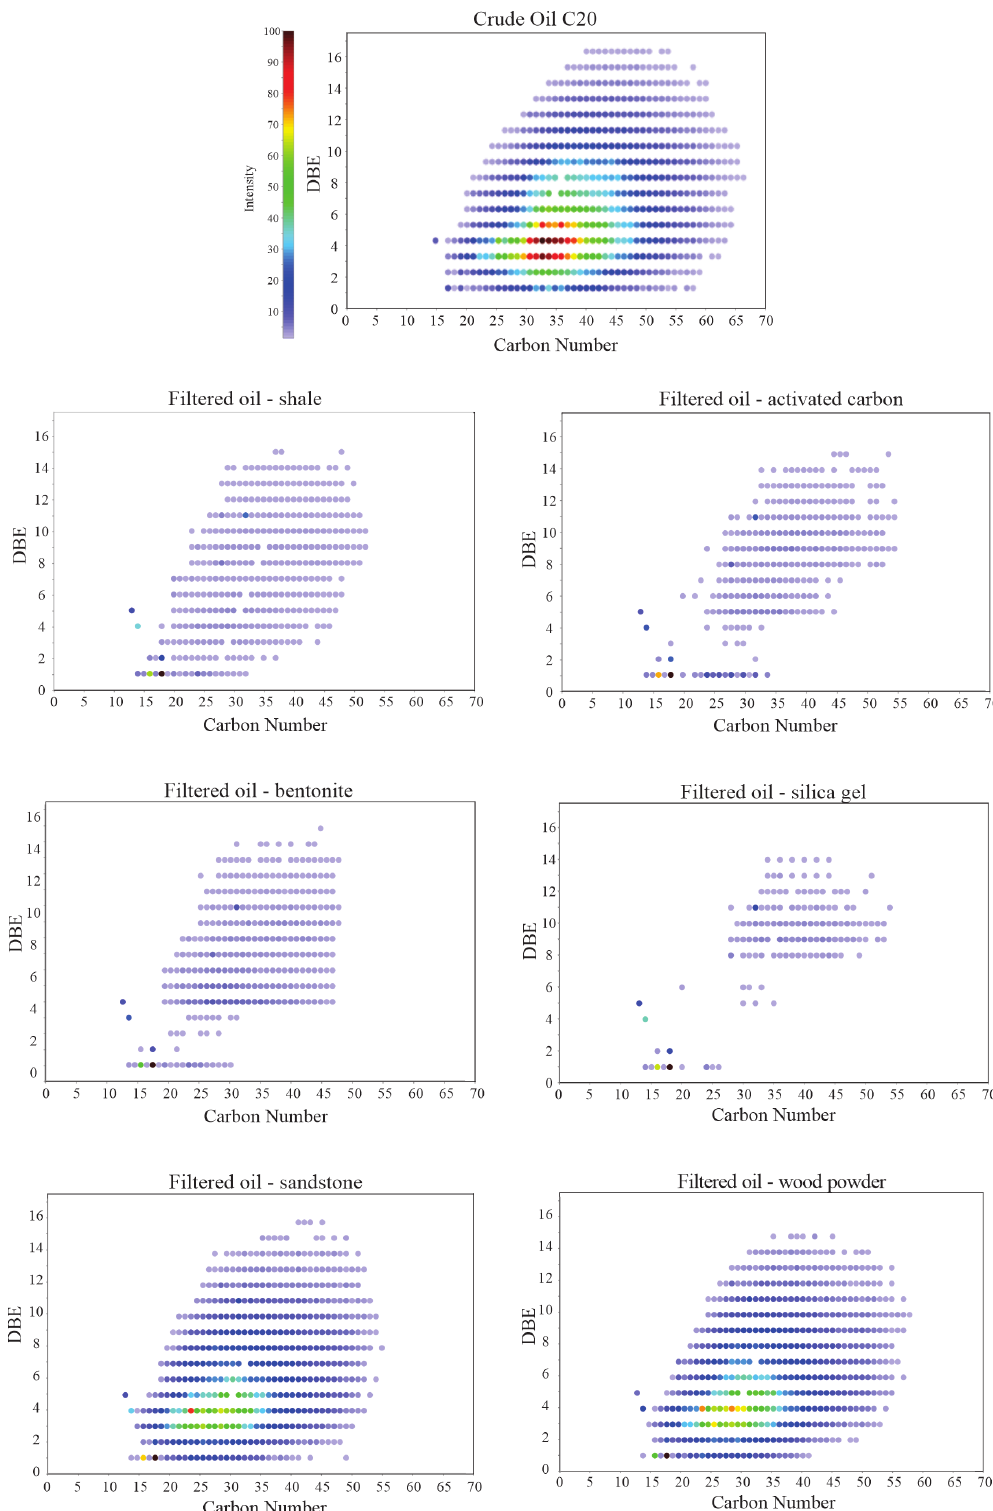
Figure 6. Isoabundance contoured plots of DBE versus carbon number for the O